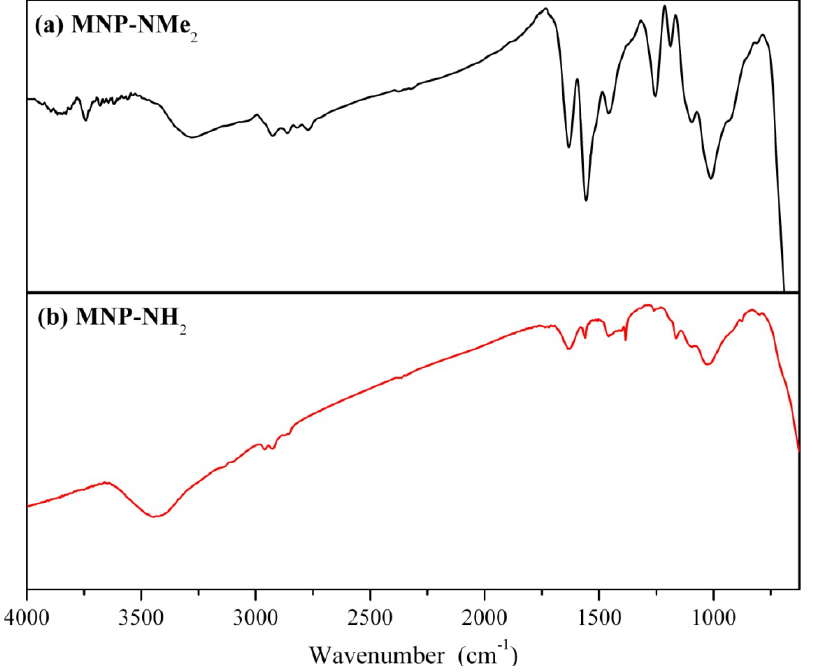
and ( b ) MNP-NH 2 2